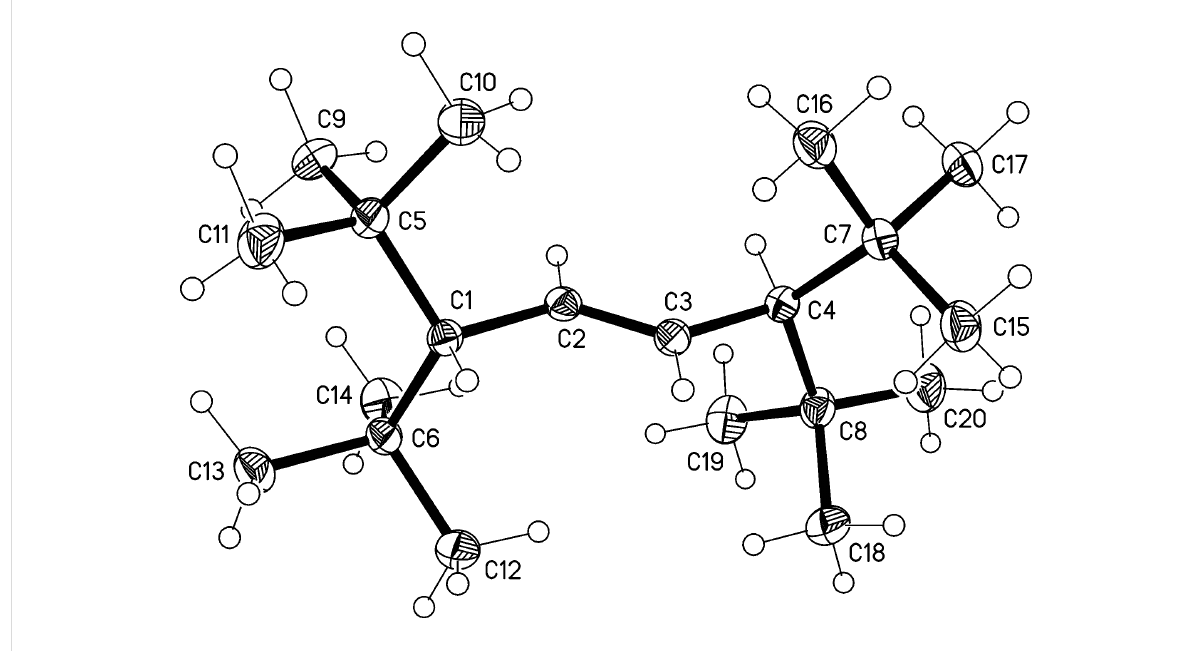
Figure 1: The structure of compound 4 in the crystal. Ellipsoids correspond to 30% probability levels.